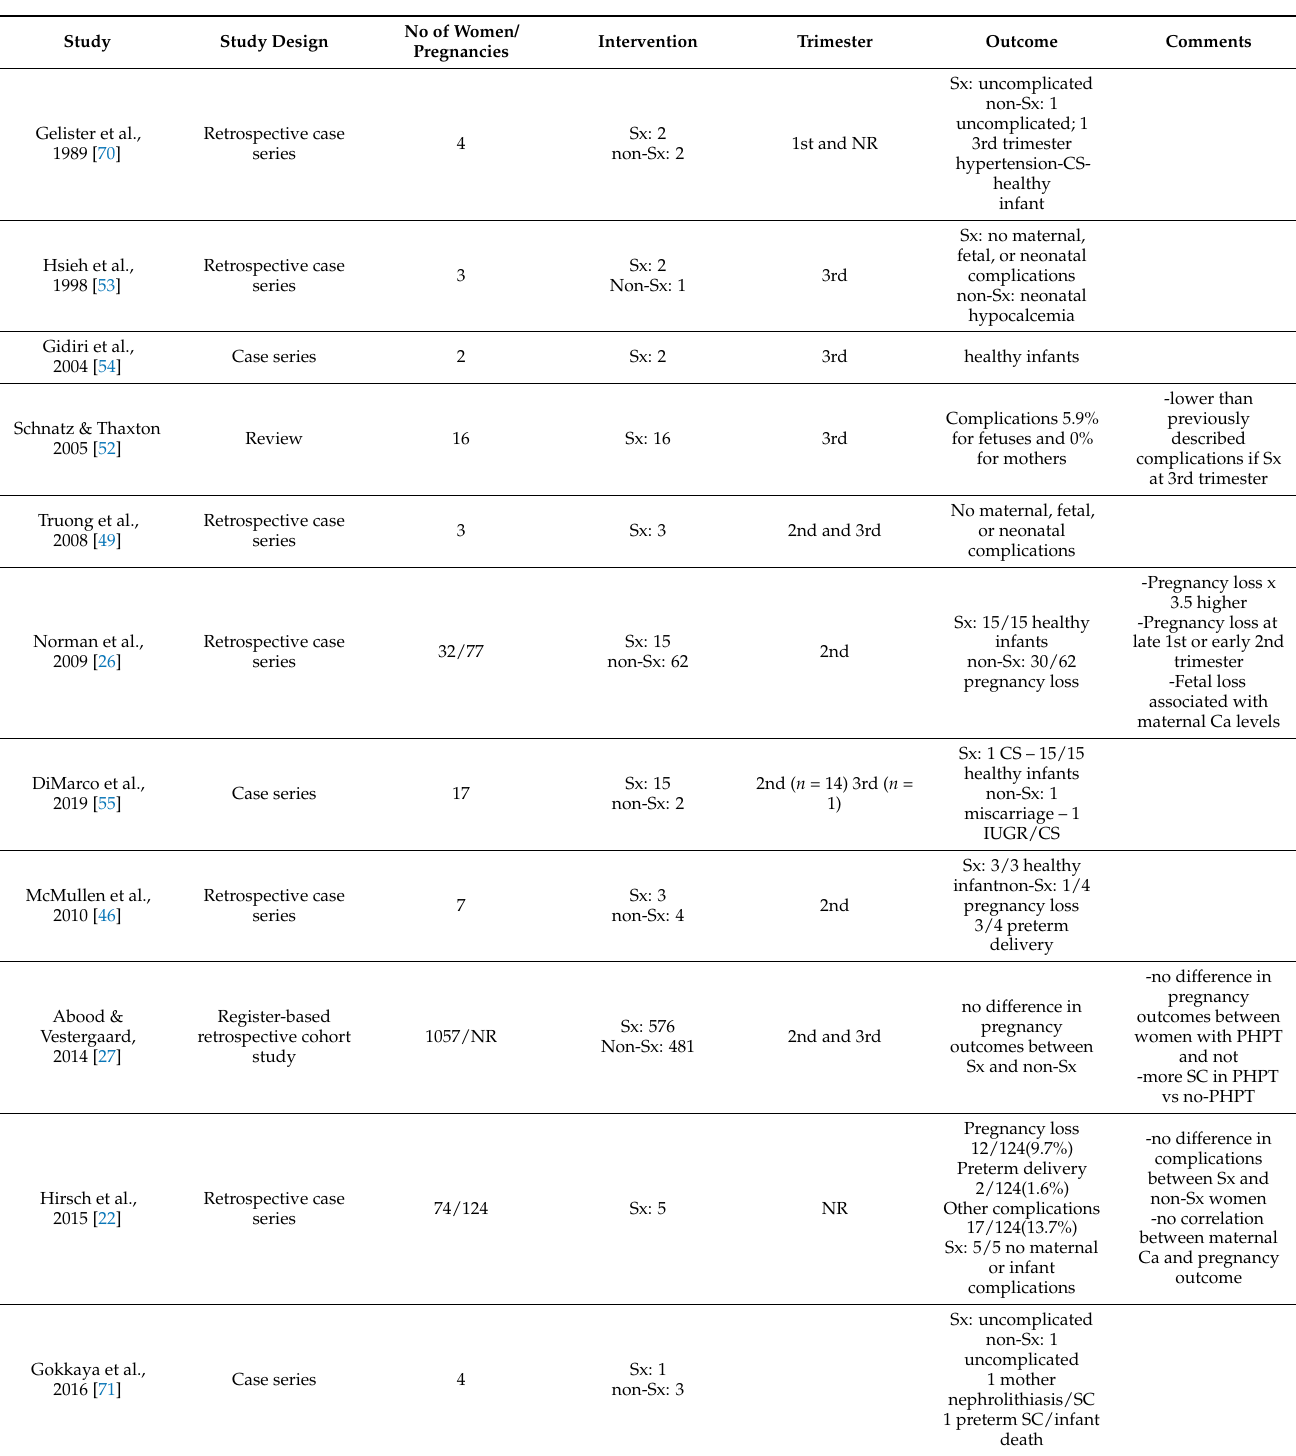
Table 1. Outcomes of surgical and pharmacological management of primary hyperparathyroidism in